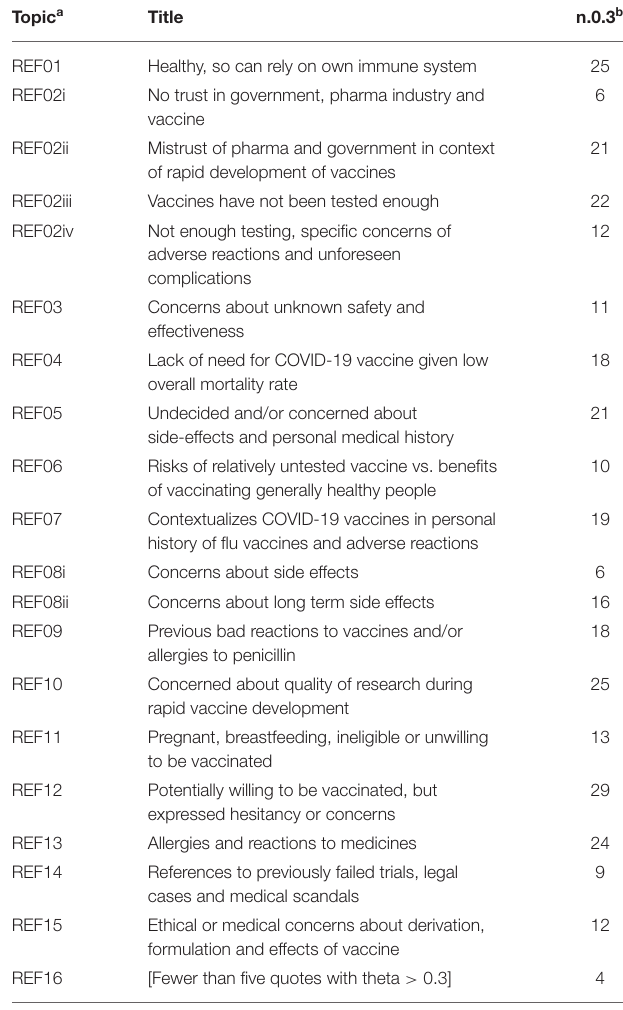
TABLE 2 | Topics summarizing reasons for intending to refuse a COVID-19